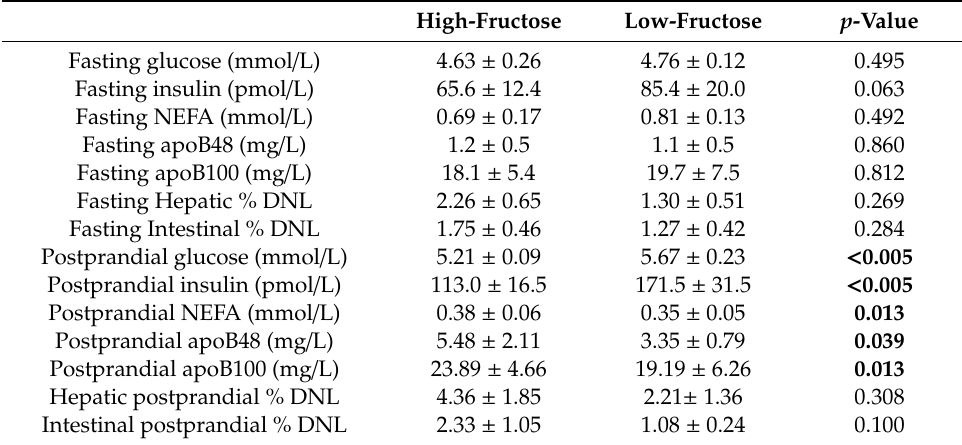
Table 1. Fasting and mean postprandial (0–420 min) plasma glucose, serum insulin, plasma NEFA, TRL apoB48 and TRL apoB100 in response to high- and low-fructose drinks. Values are mean ± SEM ( n =